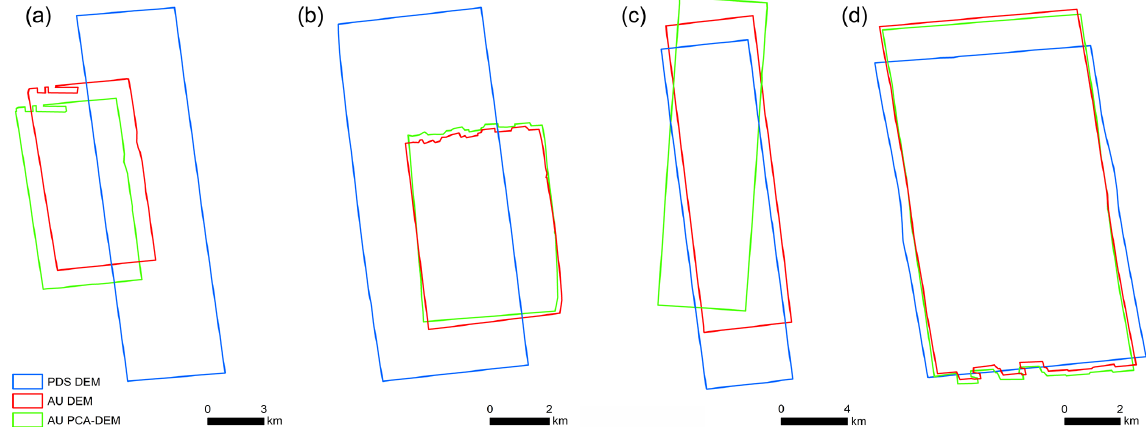
Figure A4. Footprints generated from each HiRISE DEM (AU and PDS) for each of the four sites. Note the large shifts after pc_align with the AU DEMs for sites 1 ( a ) and 3 ( b ). In each of these cases, pc_align dramatically increased the RMSE of AU DEMs against the reference